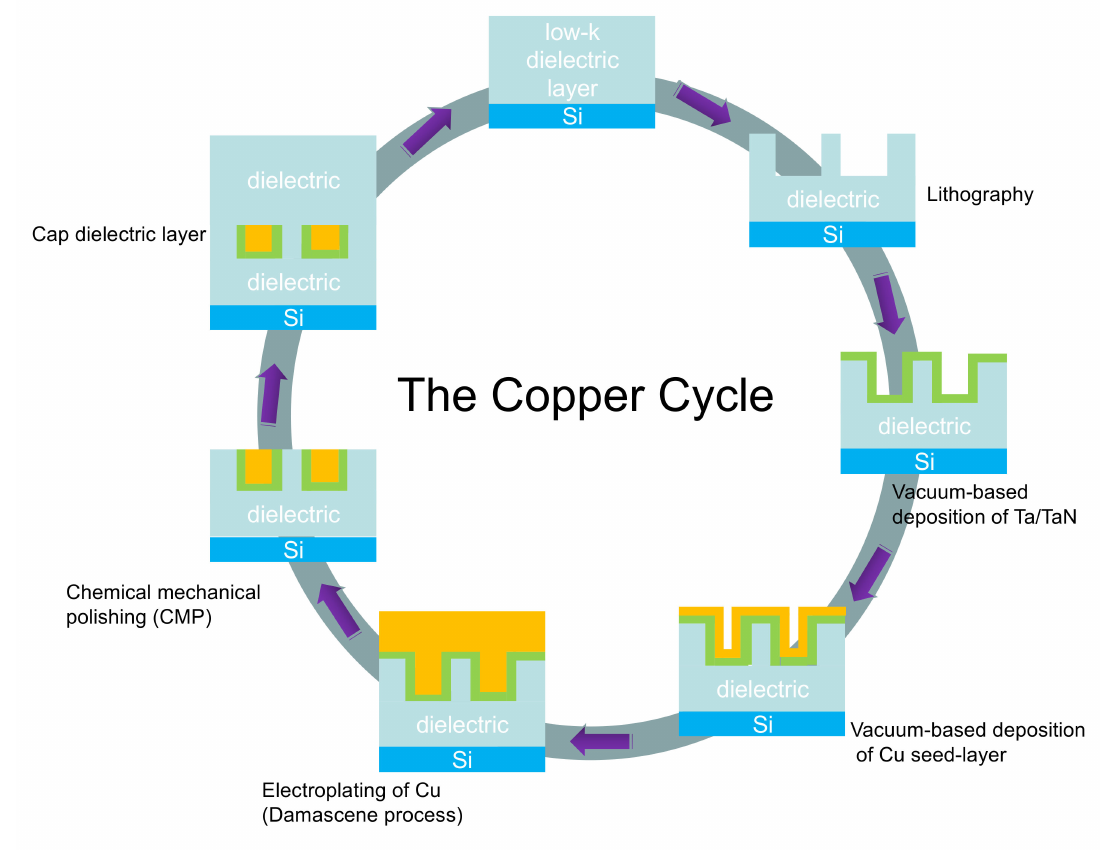
Figure 1. Schematic demonstration of the Cu